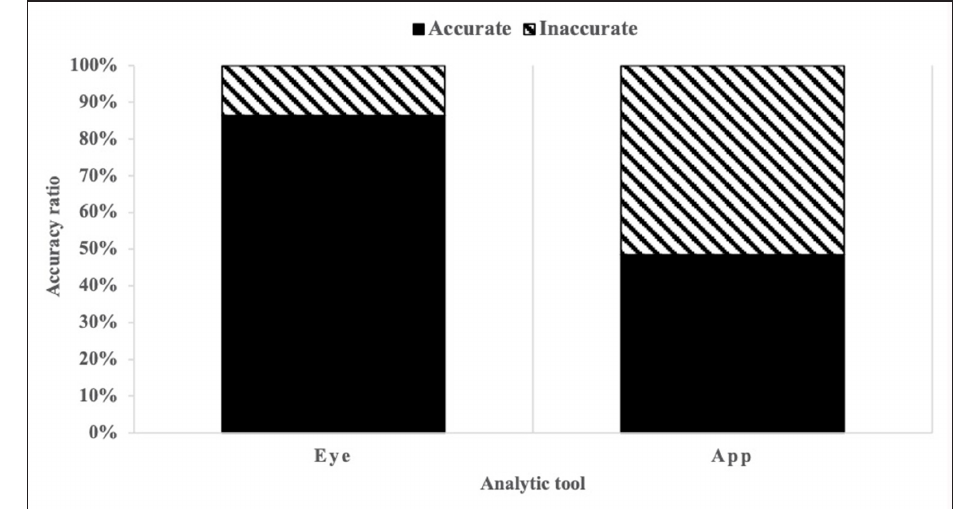
Figure 1 Graphical representation of the proportions of accurate and inaccurate responses for both analytic